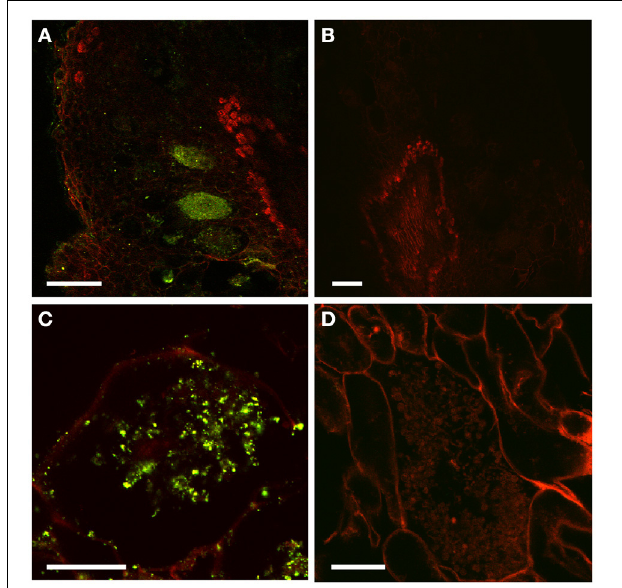
FIGURE 2 | Immunolocalization of PAA in D. trinervis nodules. (A–C). A strong signal is detected in cells infected by Frankia . No signal is present in the vascular bundle or in non-infected cells. (B–D) No signal is detected in control sections incubated with the secondary antibody alone. Scale bars: A, B: = 50 µ m; C, D: 25 µ